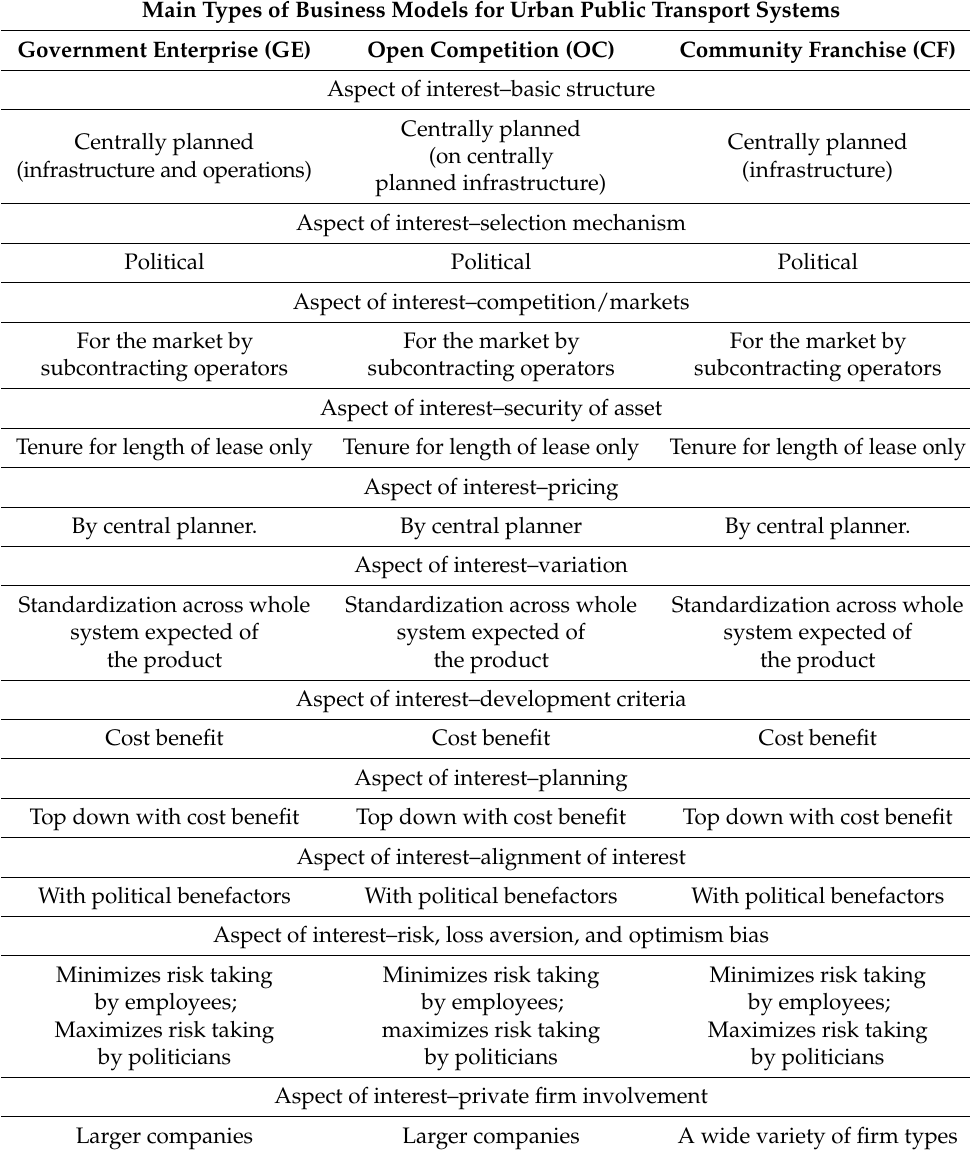
Table 1. Main types of business models for urban public transport